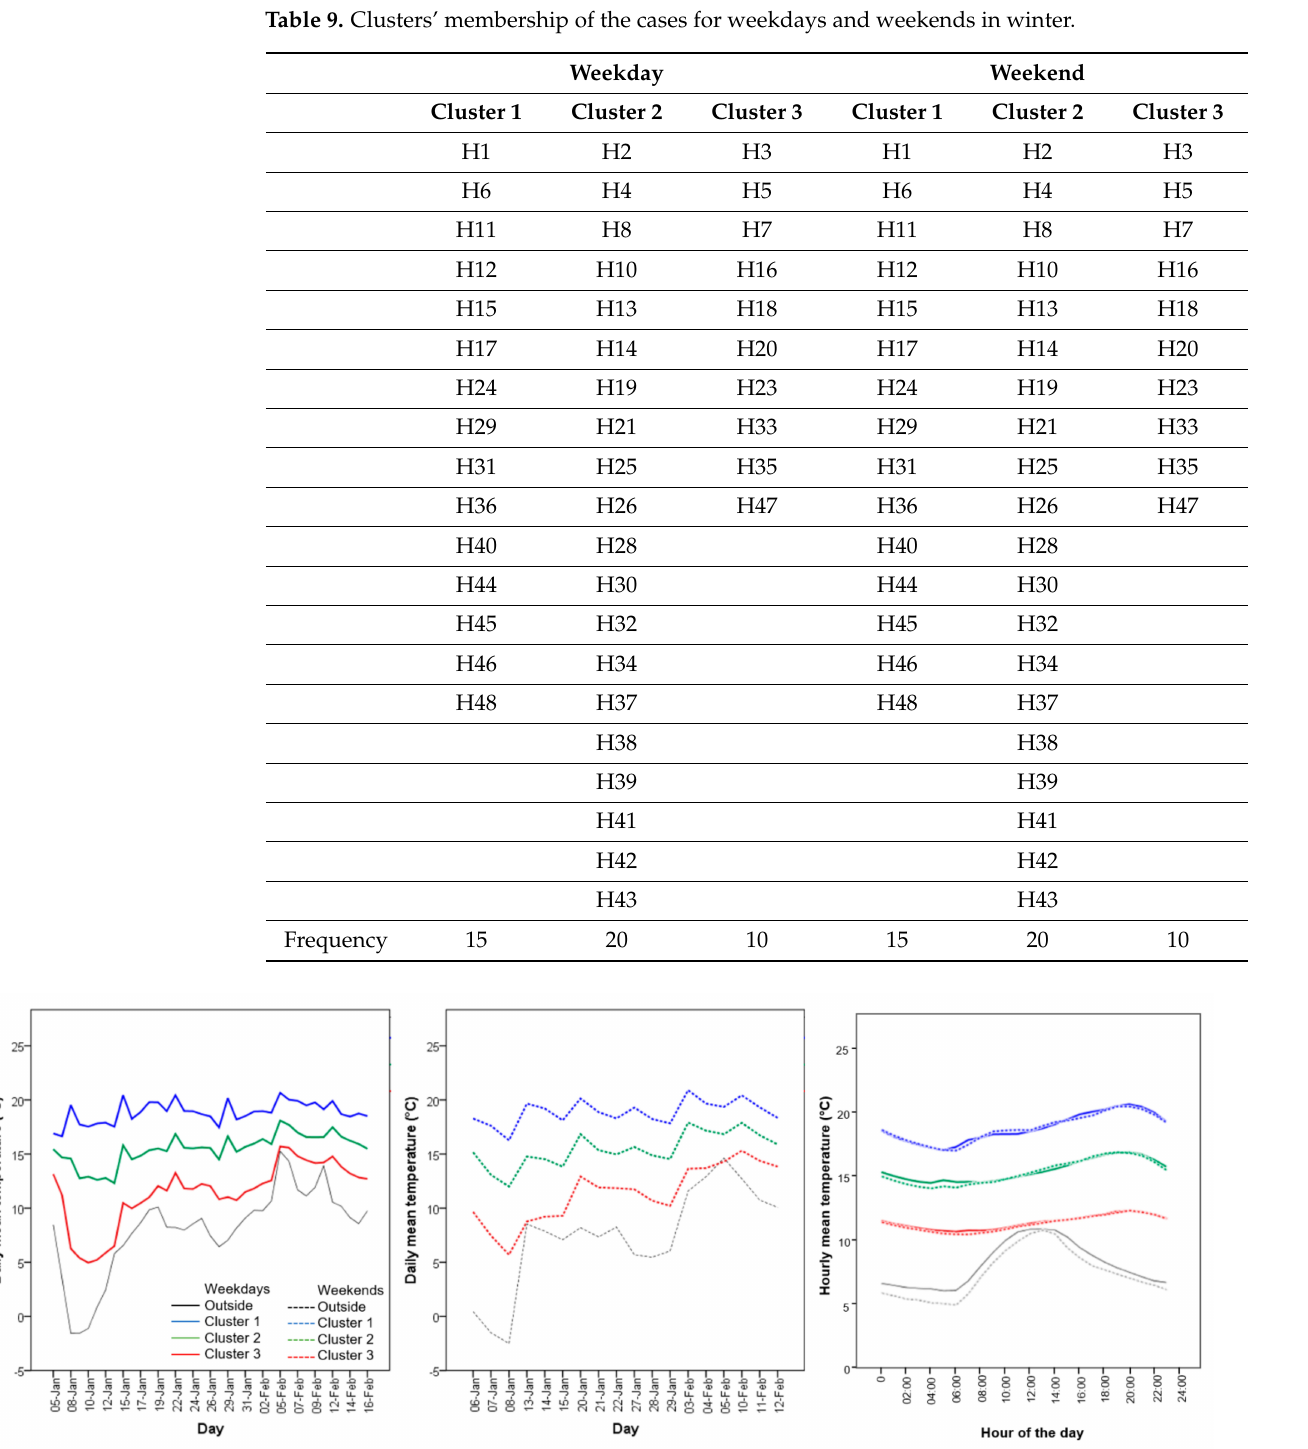
Figure 5. Mean daily temperature for weekdays ( left ) and weekends ( centre ); mean hourly tem- perature profiles for both weekdays and weekends ( right ) of the three clusters, together with external